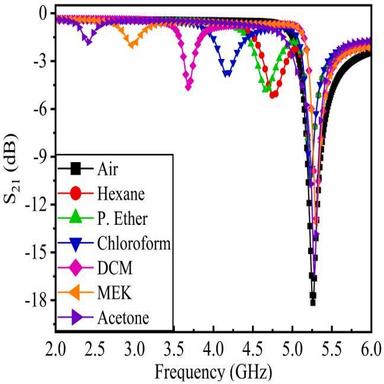
Simulated sensor performance for real-life liquid samples.